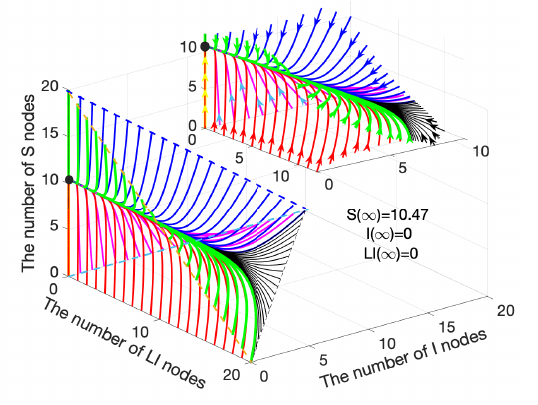
Figure 3. Variation of S, I and LI nodes when R 0 <